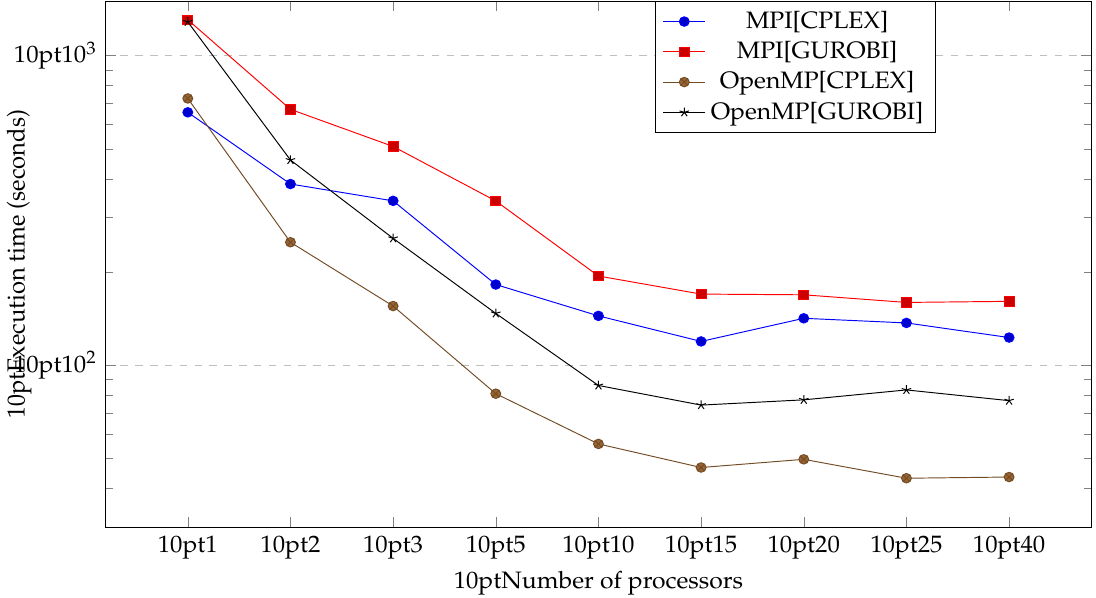
Figure 4. Performance of each level of parallelization. Comparison using all the resources with message-passing (MPI) or OpenMP with several optimization packages (CPLEX and GUROBI). Table 1. Comparison between several configurations with MPI and OpenMP in a hybrid mode. Time for each solver is expressed in seconds. The number of processors used in each parallel level is also